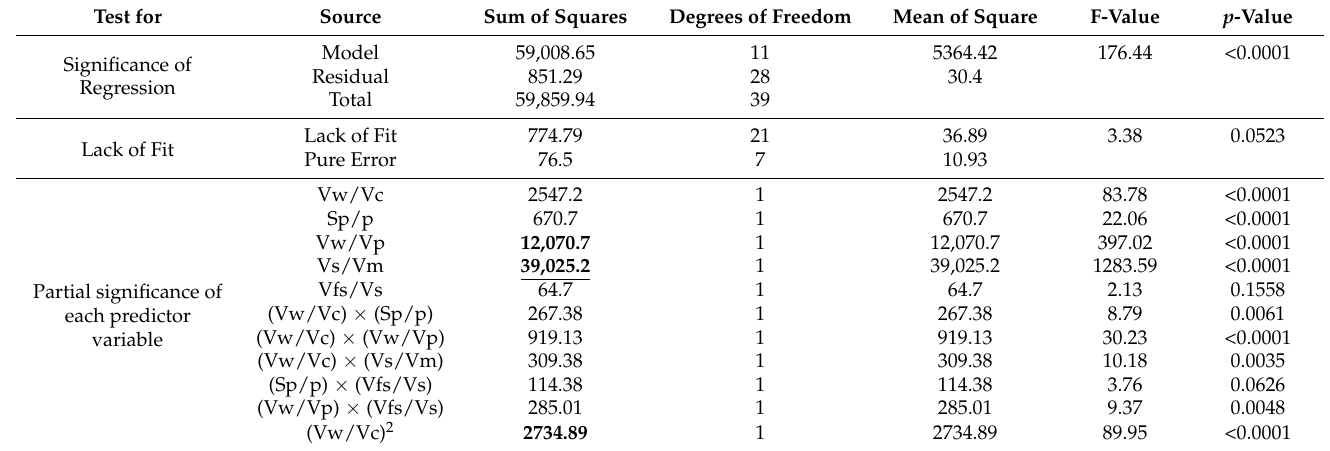
Table 5. ANOVA for the D-flow response.